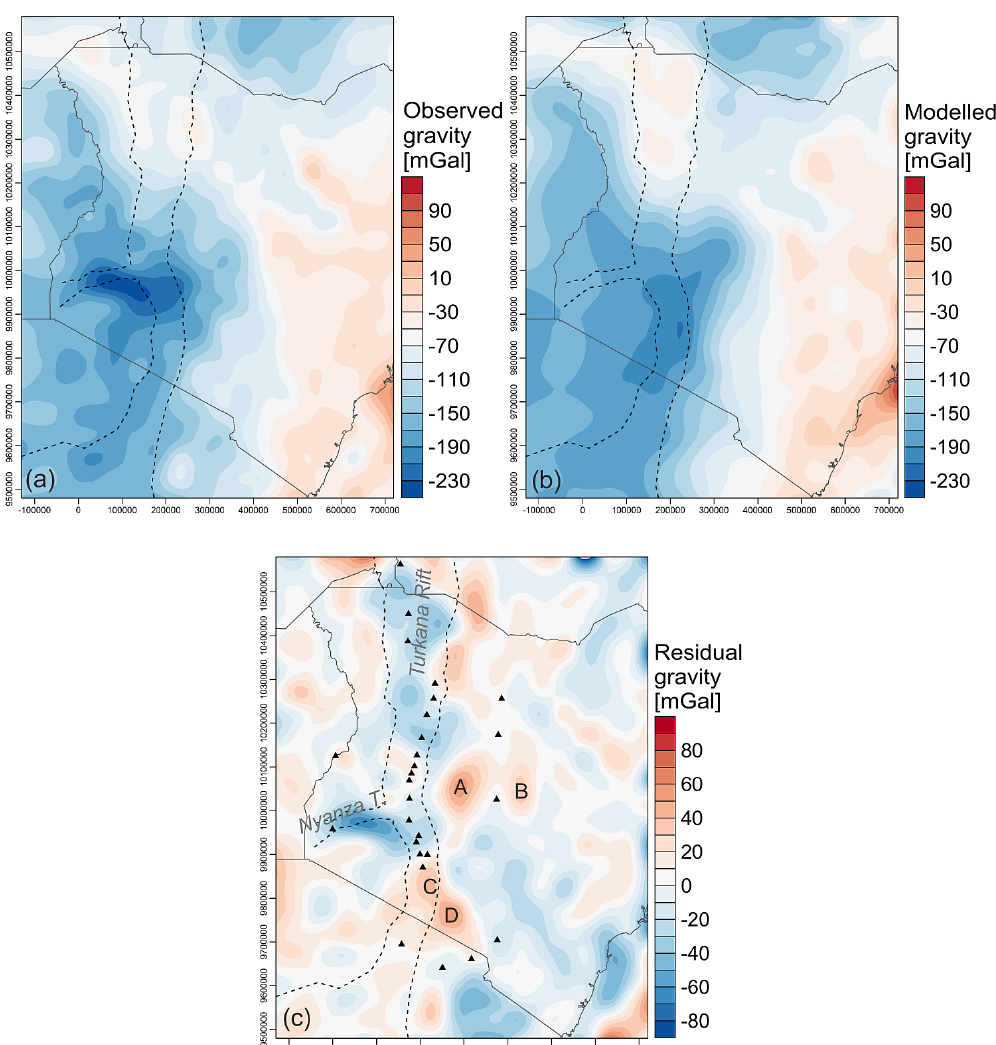
Figure 6. Gravity anomalies. (a) Observed Bouguer (onshore) and free-air (offshore) anomalies (Eigen-6C4; Förste et al., 2015). This dataset and corresponding reductions are available from http://icgem.gfz-potsdam.de/ICGEM/Service.html. (b) Calculated anomalies of the final model. (c) Residual gravity (observed minus calculated anomalies) of the final model; black triangles mark volcanoes (from the Global Volcanism Program, Department of Mineral Sciences, Smithsonian Institution, http://volcano.si.edu/). For comments on residual anomalies A–D, refer to main